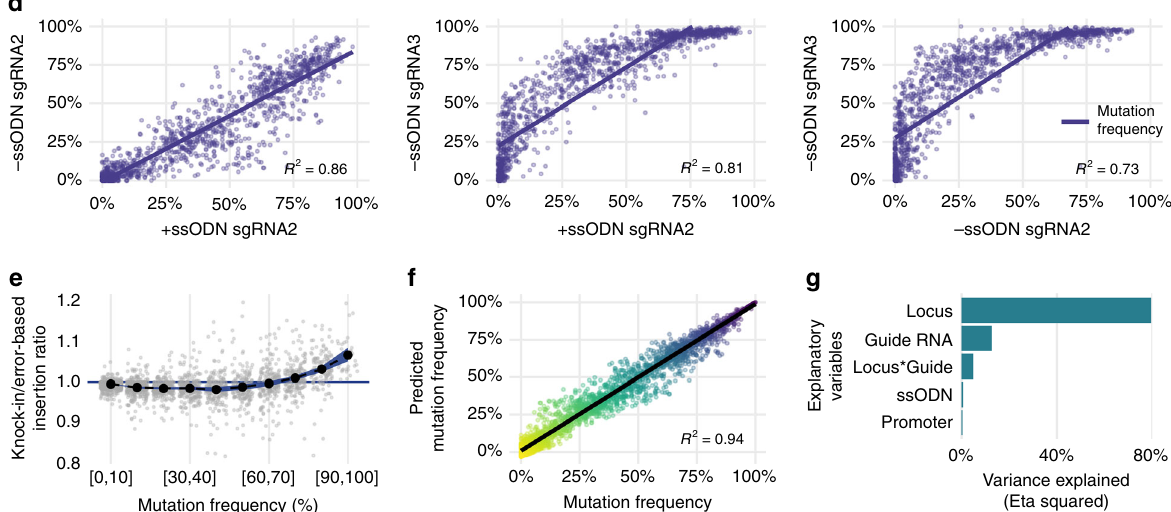
negligible effect, with less than 1% together. These results con- fi rmed that IR locus and guide RNA are major determinants of